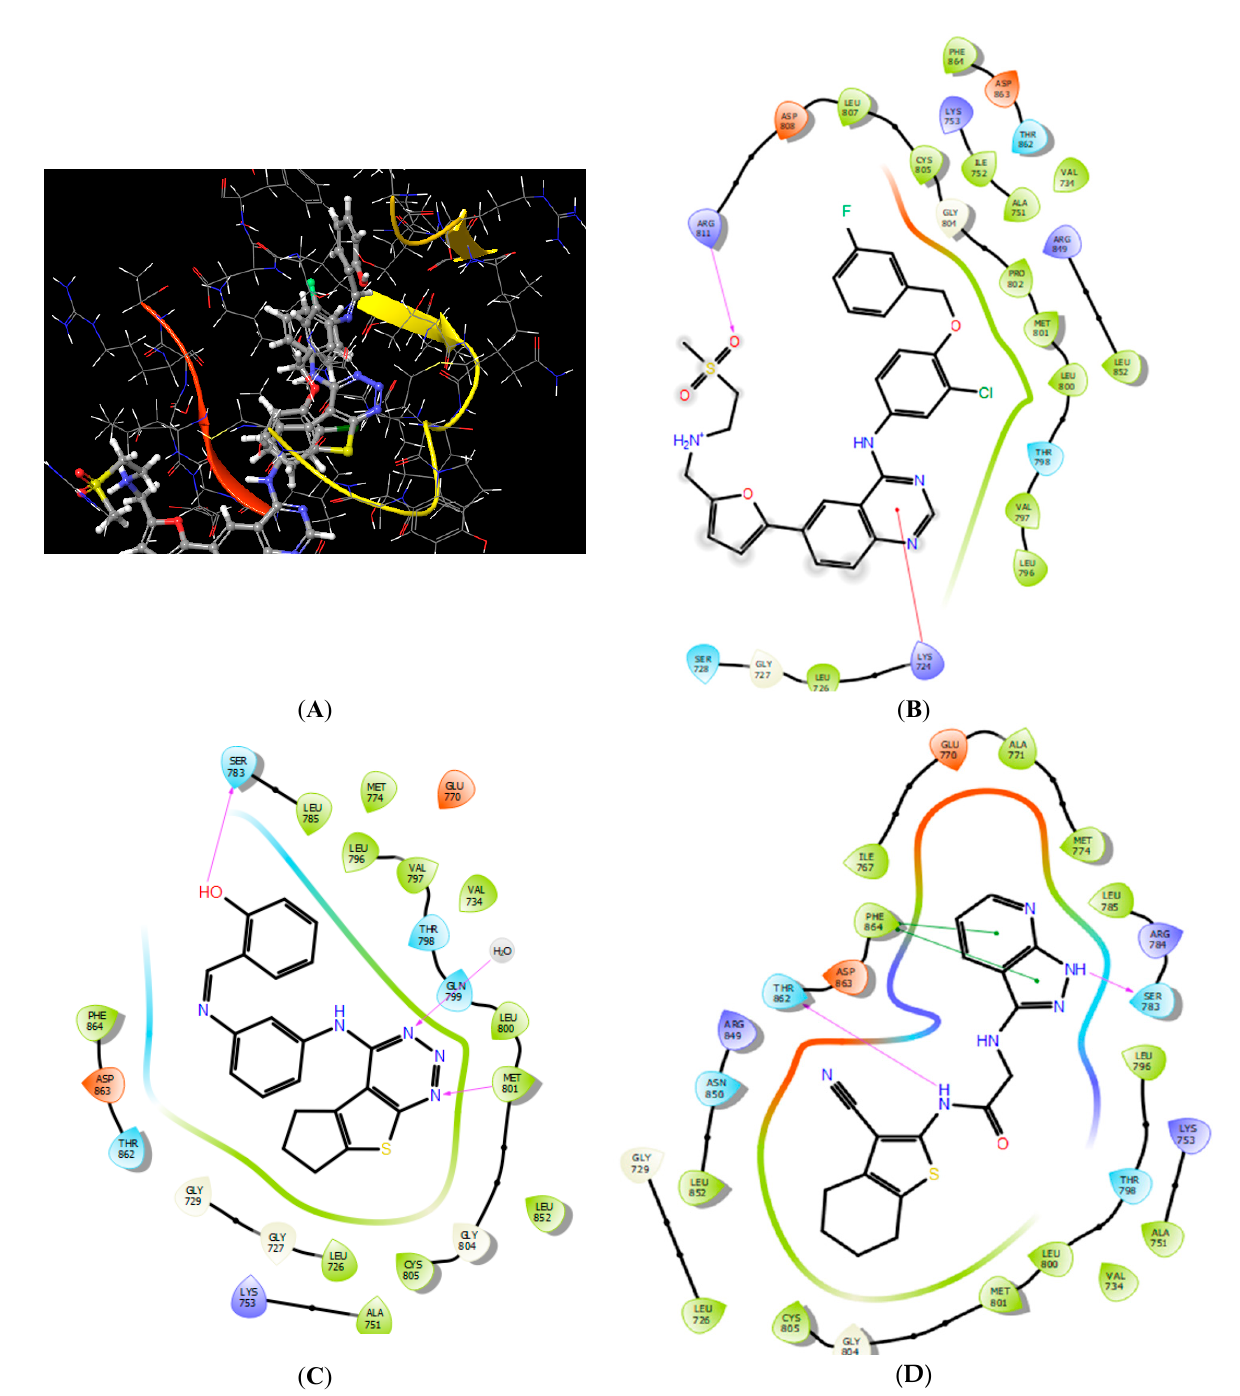
Figure 5. ( A ) Three-dimensional binding modes and overlay of lapatinib ( 4 ), compound ( 15a ), and compound ( 21a ) in the catalytic domain of HER2 (PDB 3PP0). ( B ) 2D representation of lapatinib ( 4 ) in the catalytic domain of HER2. ( C ) 2D representation of compound ( 15a ) in the catalytic domain of HER2. ( D ) 2D representation of compound ( 21a ) in the catalytic domain of HER2.